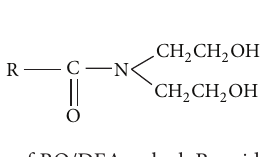
Figure 1: Structure of RO/DEA polyol, R-residue of saturated and unsaturated fatty acid C 12 -C 22 .